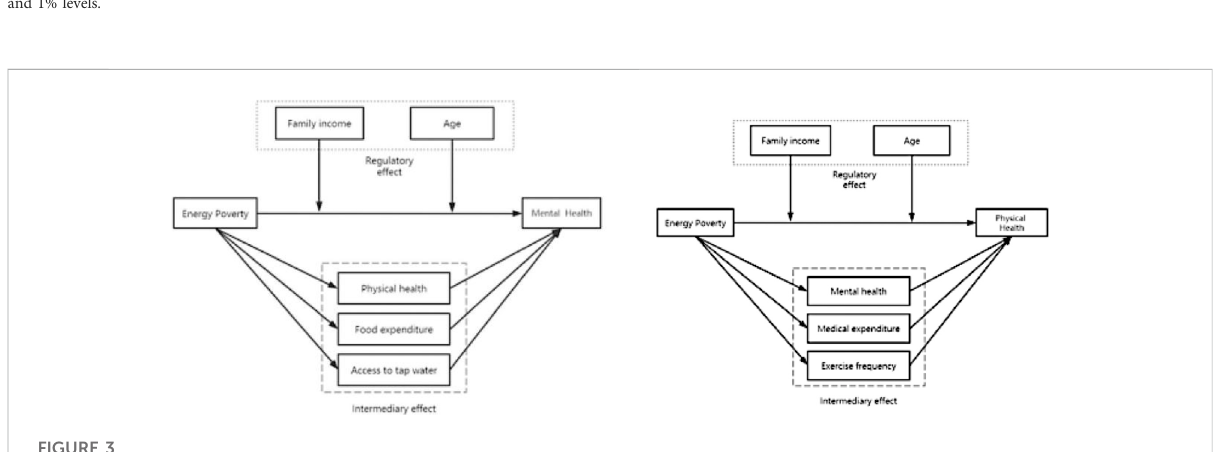
FIGURE 3 Mechanism chart of the impact of energy poverty on mental and physical